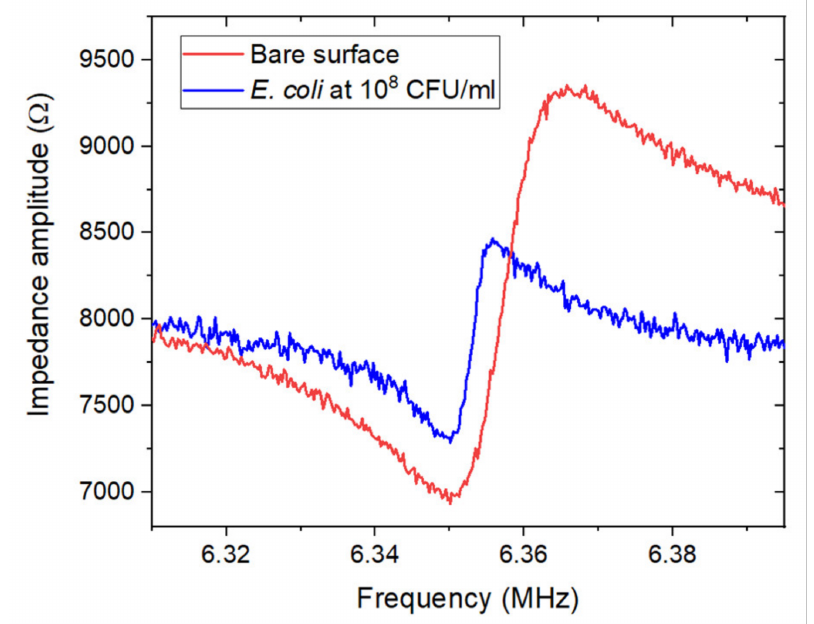
Figure 2. Example of the impedance amplitude measured near the resonant frequency (f r = 6.35 MHz) for ZnO/GaAs membrane (220 µ m) before and after exposure for 1 h to E. coli suspension at 10 8 CFU/mL in PBS